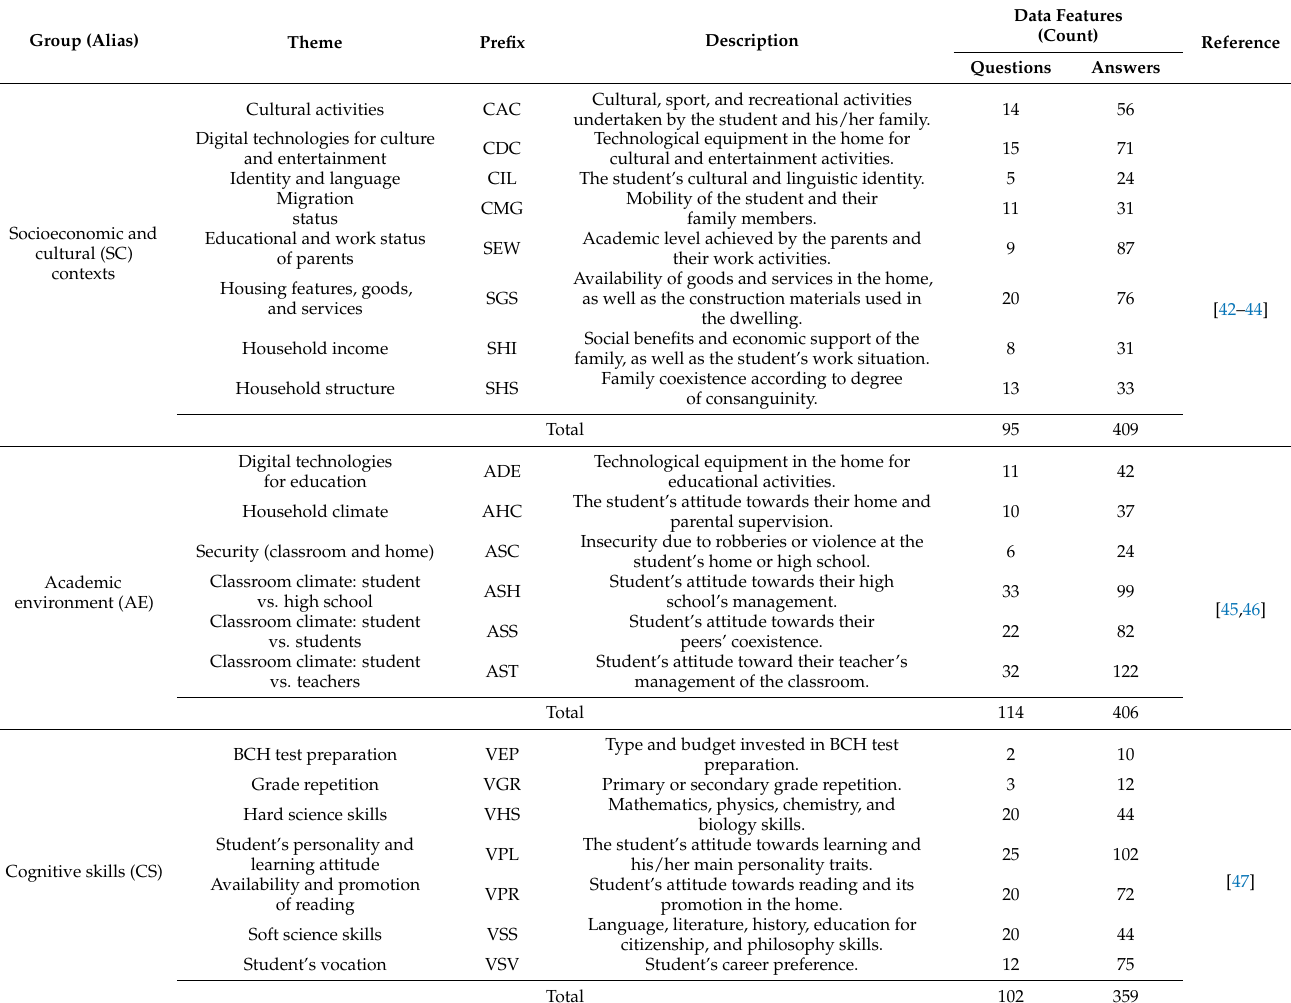
Table 3. Independent variable